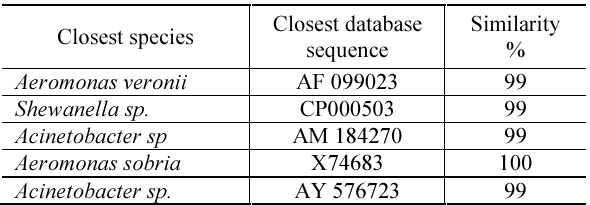
Table 2 . Molecular species of hydrocarbon-degrading bacteria from the digestive tract of fish Closest